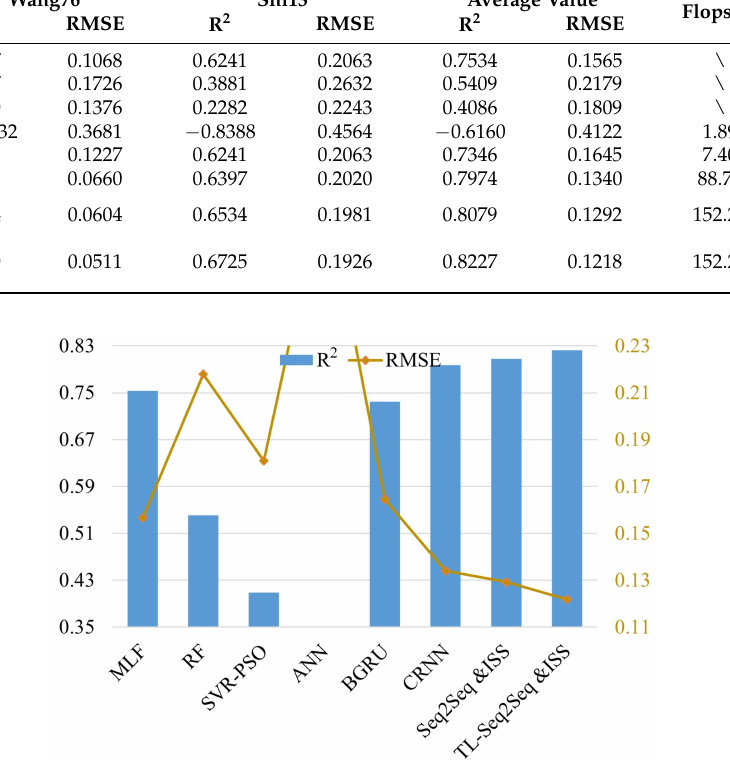
Figure 26. The performance of multiple comparison methods in average